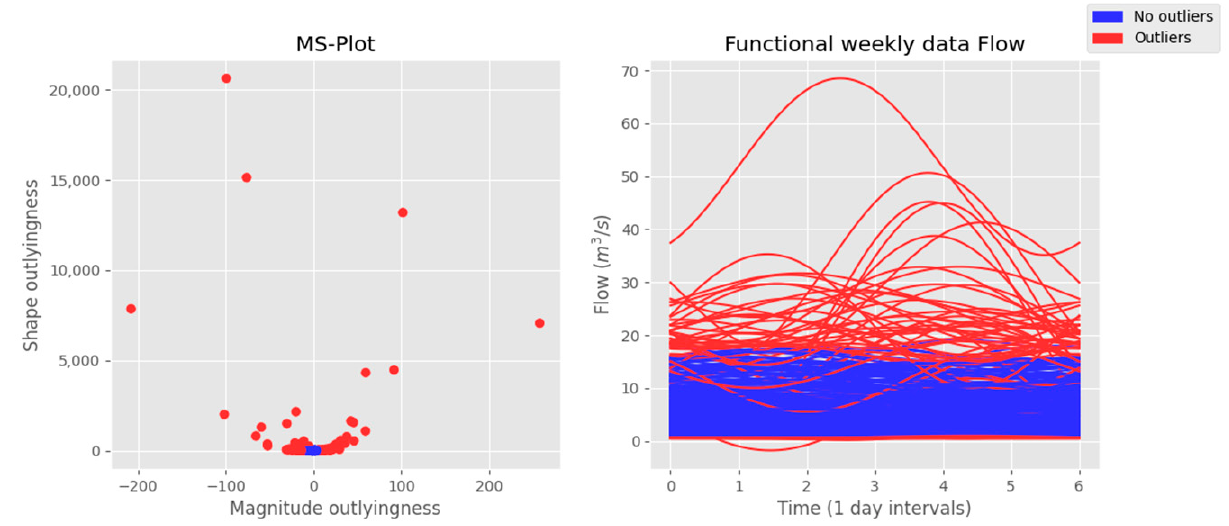
Figure 5. Results of the functional analysis on the water flow data. On the left side, a Cartesian representation of the pair of values magnitude–shape of each function is presented. The right side shows the functional plot of the weekly water flow values. Outliers are marked in red in both plots, and nonoutliers are colored in blue.